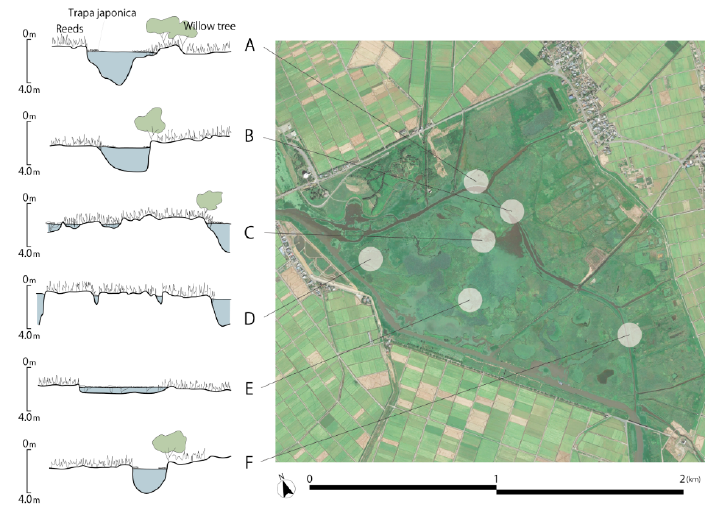
Figure 4. Diversity of water depth in the Fukushima-gata lagoon.